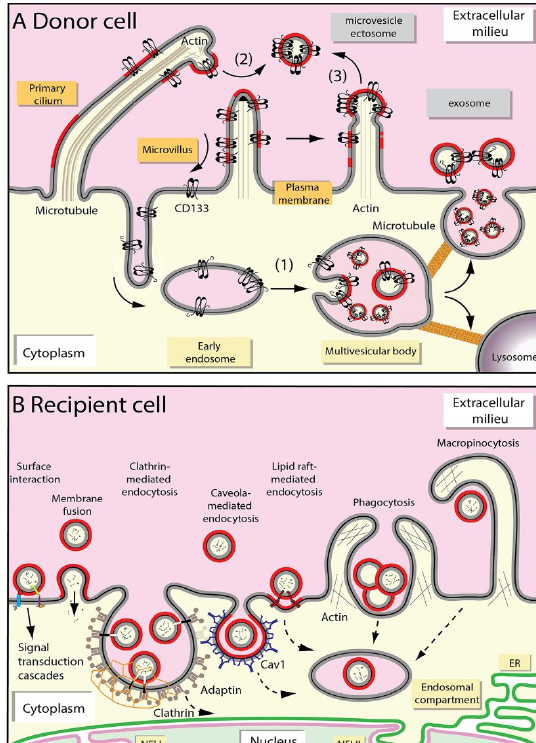
Figure 1. Mechanisms of the release of EVs by donor cell and their uptake by recipient cell. ( A ) The release of EVs from a healthy donor cell can occur by two major pathways that are not mutually exclusive. CD133 + EVs can be discharged into extracellular milieu upon fusion of multivesicular body (MVB) with plasma membrane. They will be referred to as exosomes. The internalization of CD133 and its transport to the early and late endosomal compartments can be mediated by its ubiquitination and interaction with syntenin-1. The biogenesis to small intraluminal vesicles within late endosome / MVB involves an inward invagination and budding of the limiting membrane of the endosome toward its own lumen (1). MVB could also fuse to lysosomes, leading to proteolytic degradation of CD133 and other proteins. The endosome movement requires a microtubule network. Alternatively, CD133 + EVs can bud from plasma membrane, notably protrusions such as primary cilium (2) or microvilli (3). They will be referred to as microvesicles or ectosomes. Cholesterol-dependent membrane microdomain (red membrane segment) can play a role in these budding processes. ( B ) The transfer of EV cargoes to the neighboring or distant recipient cell can occur by several mechanisms. The receptor-mediated binding of EVs to recipient cell could promote a signaling cascade, and hence elicit a pleiotropic response in recipient cells. Fusion of EVs with plasma membrane might occur, and consequently release randomly their content into cytoplasm of host cells. In addition, recipient cells can internalize EVs en route to intracellular molecular targets. Various mechanisms of endocytosis were reported. Clathrin-dependent mechanism required adaptins, which connect membrane cargo to clathrin forming a polyhedral lattice that surrounds the vesicle. Caveolin-1 (Cav1) plays a role in caveola-mediated uptake. Caveolae have a flash-shaped structure and are enriched in cholesterol and sphingolipids. Other lipid raft-mediated EV internalization processes independent of clathrin and caveolin are also proposed models of endocytosis. Phagocytosis and macropinocytosis are alternative mechanisms implicated in the internalization of EVs (see main text for details). After endocytosis, the EV content can be transferred to the cytoplasm of the recipient cells upon fusion of EVs with endosomal membrane and / or transported to nucleus (Figures 2 and 3). The nucleoplasmic reticulum can be involved in the latter process. Both types (I and II) of nuclear envelope invaginations (NEI) are depicted. In type I NEI, only the inner nuclear membrane (INM) penetrates into nucleoplasm, whereas in type II both the INM and outer nuclear membrane (ONM). The endoplasmic reticulum (ER) is an extension of the ONM, and consequently, both membranes share certain